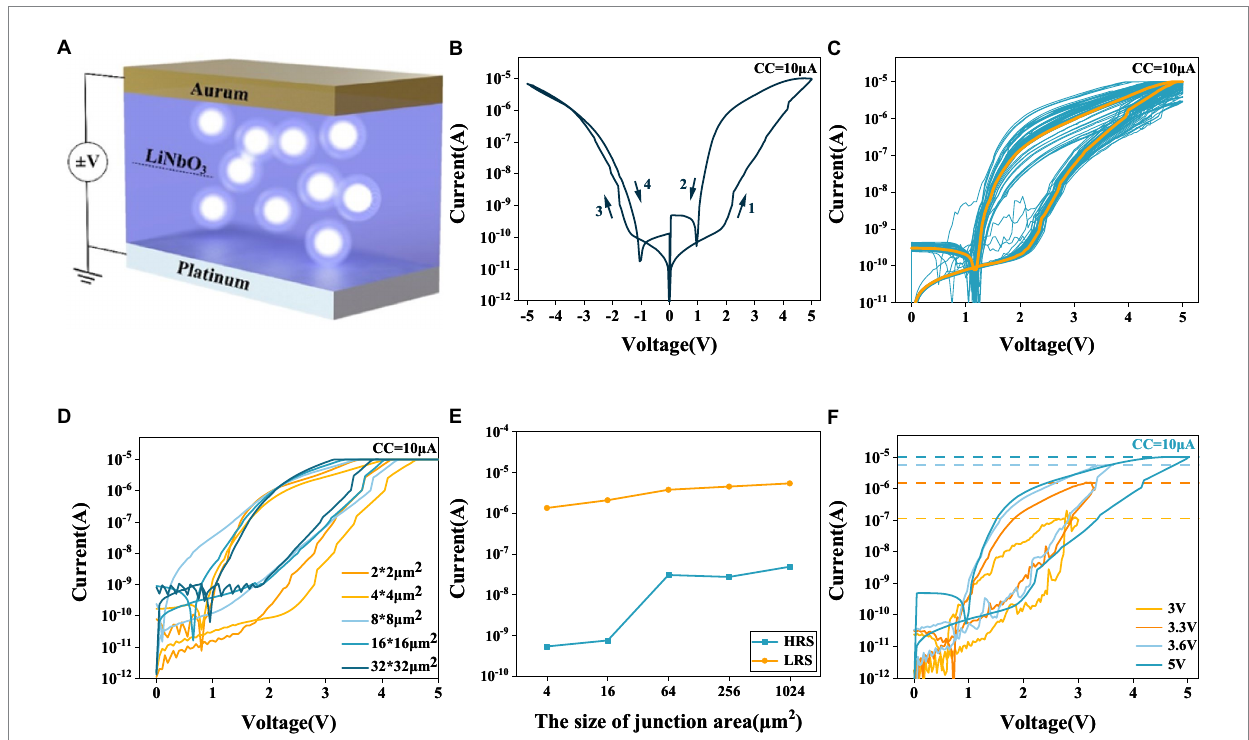
FIGURE 1 (A) Schematic structure of the Pt/LNO/Au memristor. (B) Typical I-V characteristics of the LNO memristor. (C) Fifty-cycle endurance test of the LNO memristor. (D) I-V characteristics of five LNO memristors with different sizes. (E) The currents passing through five LNO memristors with different sizes